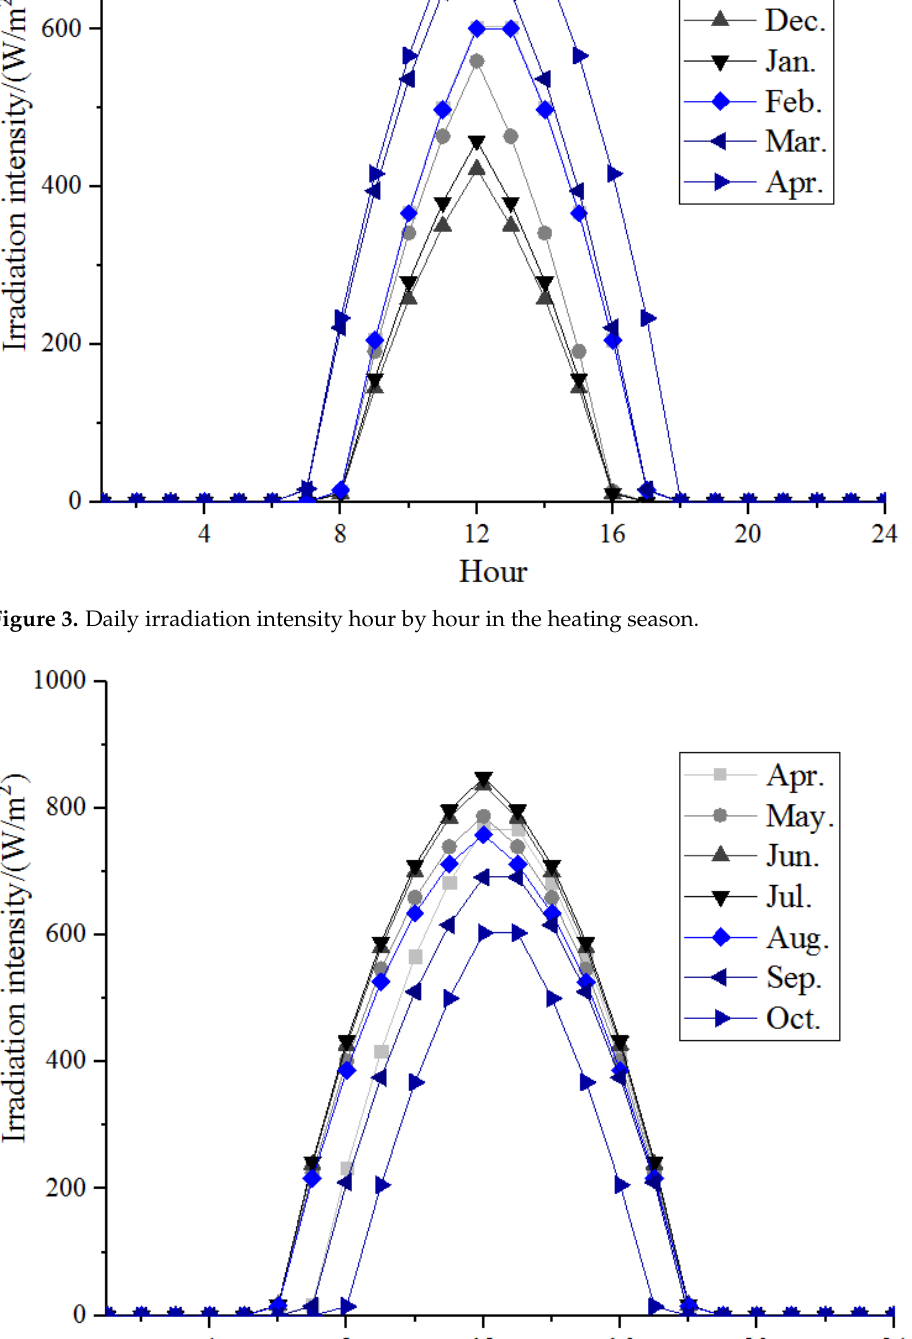
Figure 4. Daily irradiation intensity hour by hour in the non-heating season.